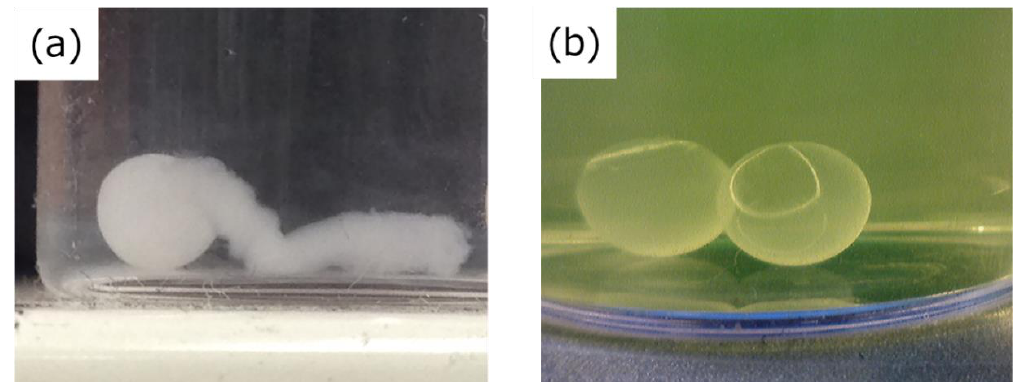
Figure 5. ( a ) Photograph of the HSBC aerogel. ( b ) Scanning electron microscopy (SEM) image of HSBC aerogel.